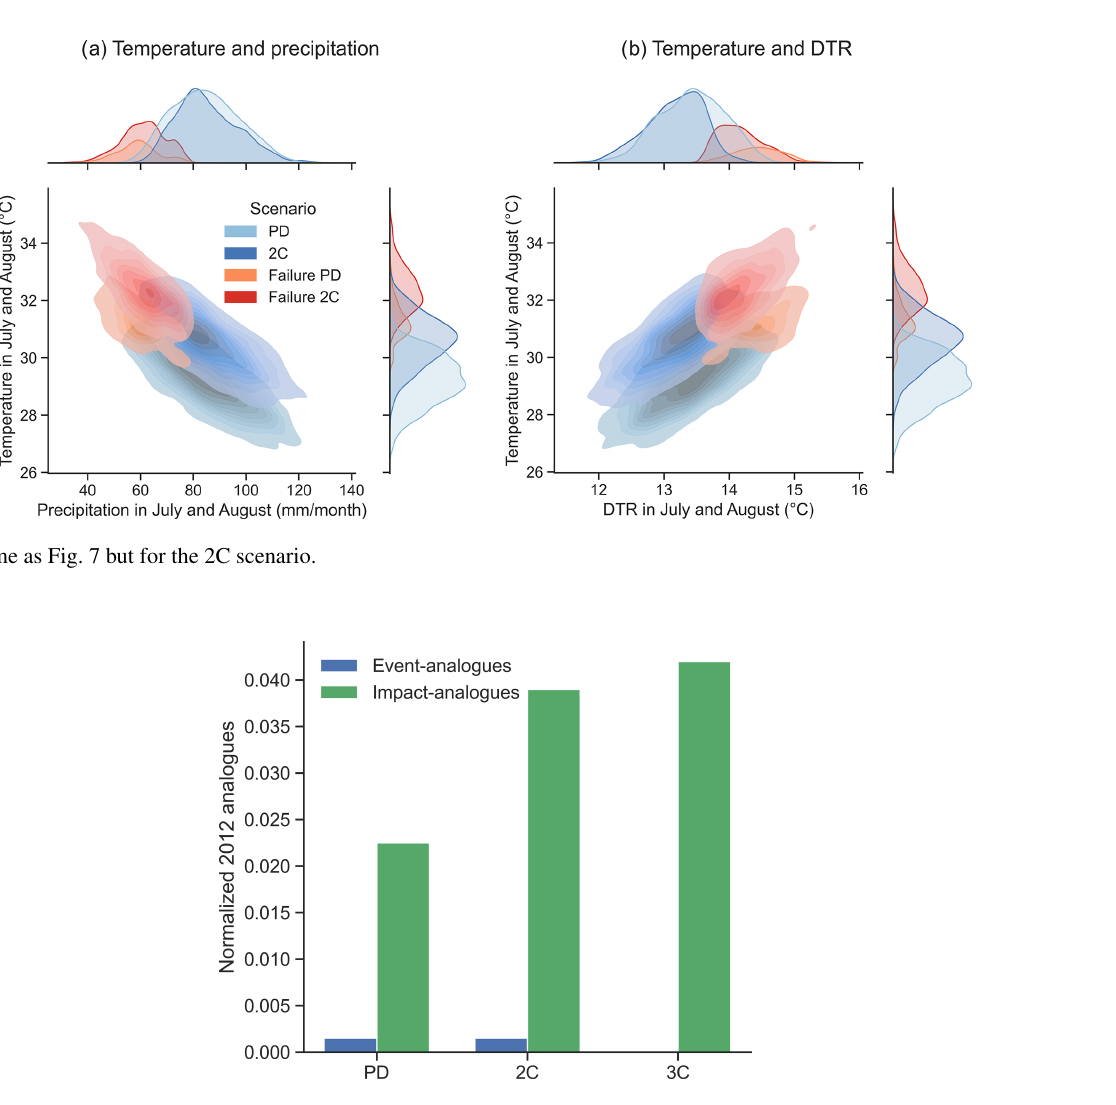
Figure C9. Event analogues (blue) and impact analogues (green) of the 2012 season for each GW scenario: present-day (PD), 2 ◦ C (2C) and 3 ◦ C (3C)